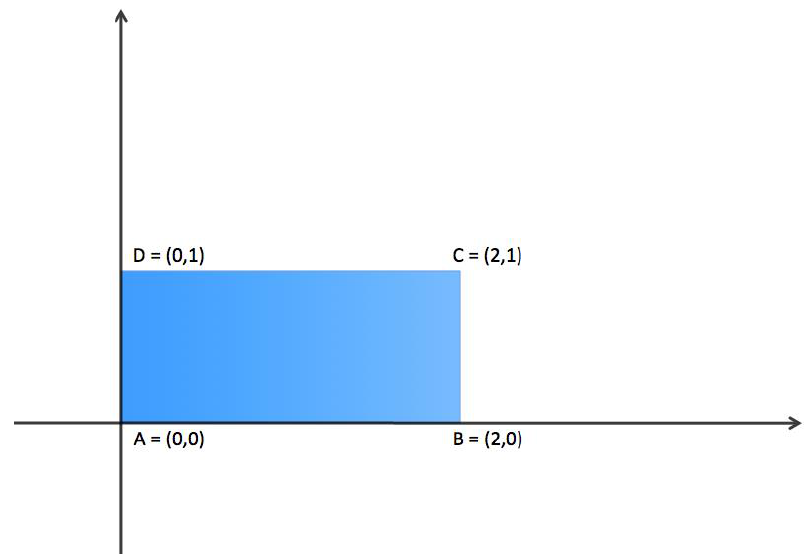
Figure 1. Bi-strategy space of any game G( z ), with z belonging to C . Any point ( x, y ) of the above strategy space represents a combination of two possible actions of the players: x represents the tons of materials chosen to manage by enterprise A for the considered year in a competitive scenario and analogously for the action y chosen by enterprise B.